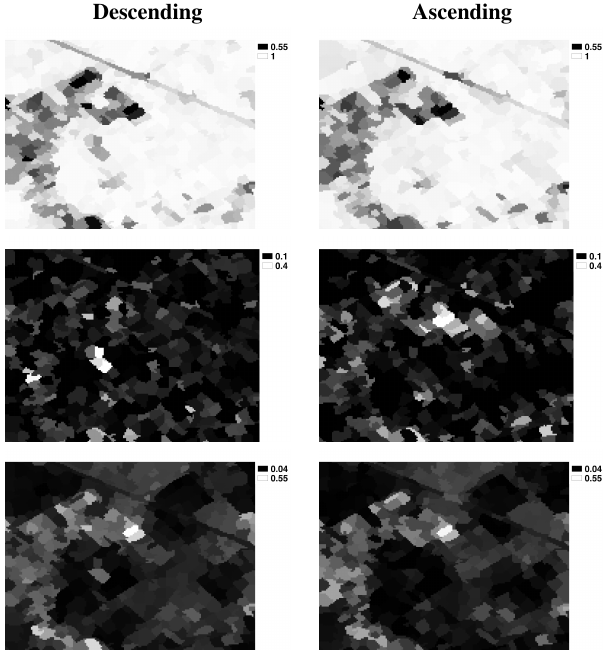
Figure 3: SAR features estimation step, computed over segments, using descending and ascending stacks. Values are normalised to [0,1]. Top: differential entropy ( H ), Middle: Coherence Between Co-Pol and Cross-Pol Polarizations ( γ V V/V H ), Bottom: Sigma nought ( σ 0 )